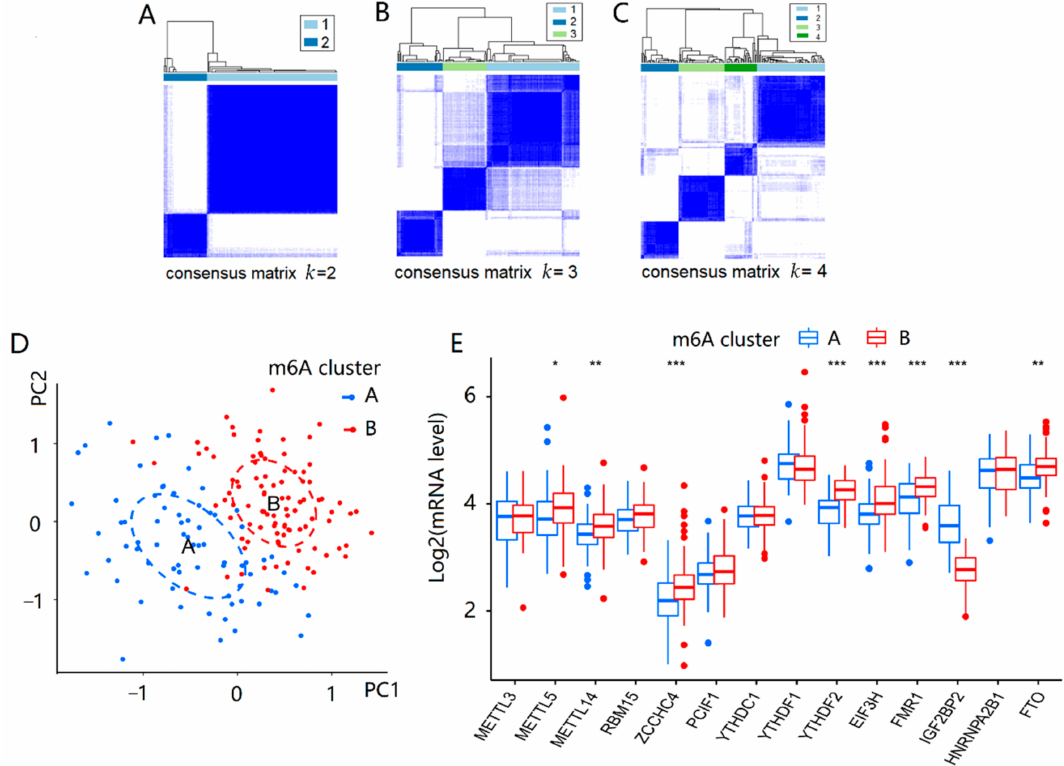
Figure 2. Consensus clustering of 14 important m6A modulators in AD patients. ( A – C ) Consensus matrices of the 14 significant m6A regulators for k = 2–4. ( D ) PCA for the expression profiles of the 14 significant m6A regulators, with remarkable differences in transcriptomes between the two m6A patterns. ( E ) Differential expression boxplot of the 14 significant m6A regulators in cluster A and cluster B. The t -test was used to analyze the differences in the expression levels of the 14 significant m6A regulators between cluster A and cluster B. The results with significant differences were marked as * p < 0.05, ** p < 0.01, and *** p <